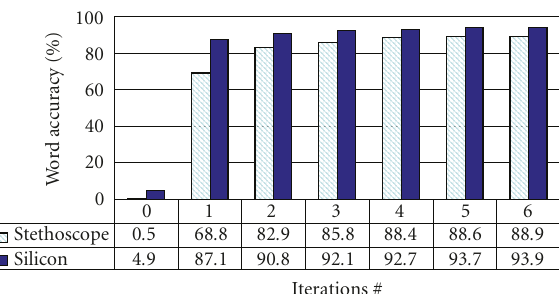
Figure 4: Nonaudible murmur recognition in a clean environment.